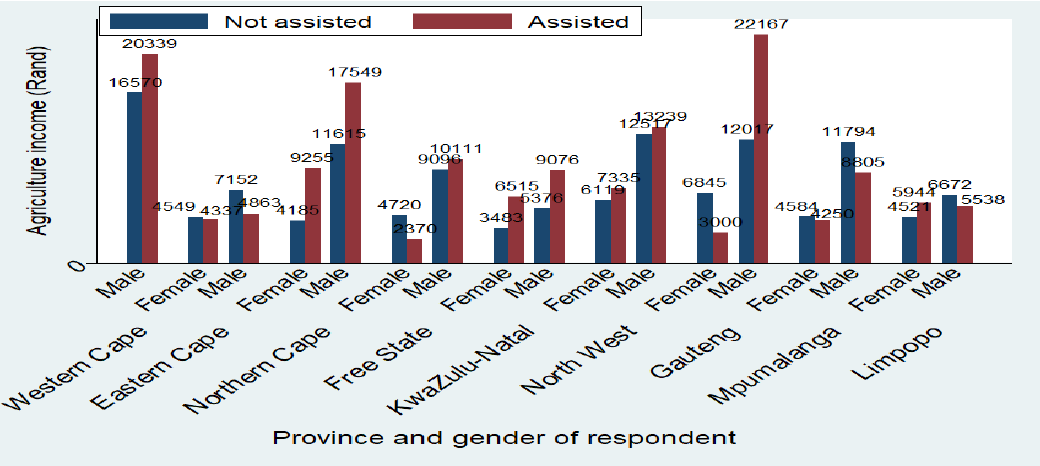
Figure 5. Average agriculture income by gender and province of respondent.